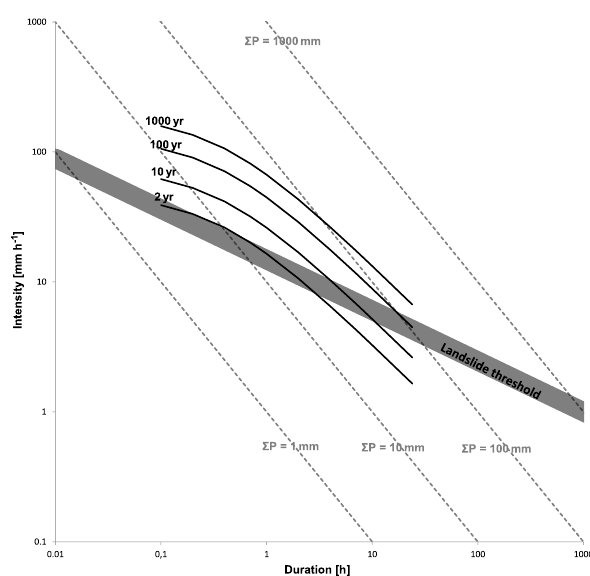
Figure 3. Schematic representation of precipitation IDF curves, iso- lines of accumulated precipitation ( (cid:54)P ) and ID threshold for shal- low landslides and debris flows (simplified from Fig.